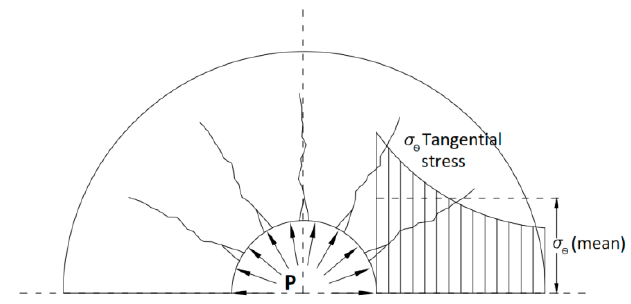
Figure 9. Fracture propagation from borehole (modified after Harada et al. 1989).